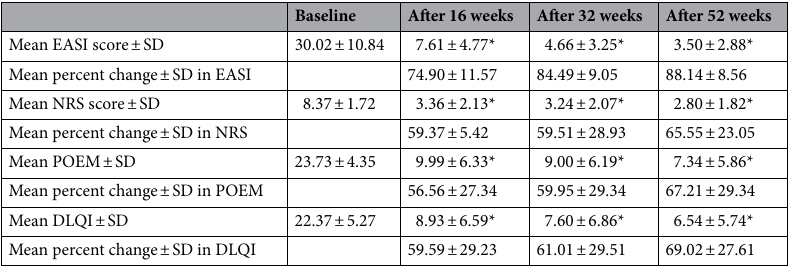
Table 2. Change in efficacy outcomes after 16, 32 and 52 weeks—all showed a significant decrease. SD, standard deviation; EASI, Eczema Area and Severity Index; NRS, Numerical Rating Scale; POEM, patient-